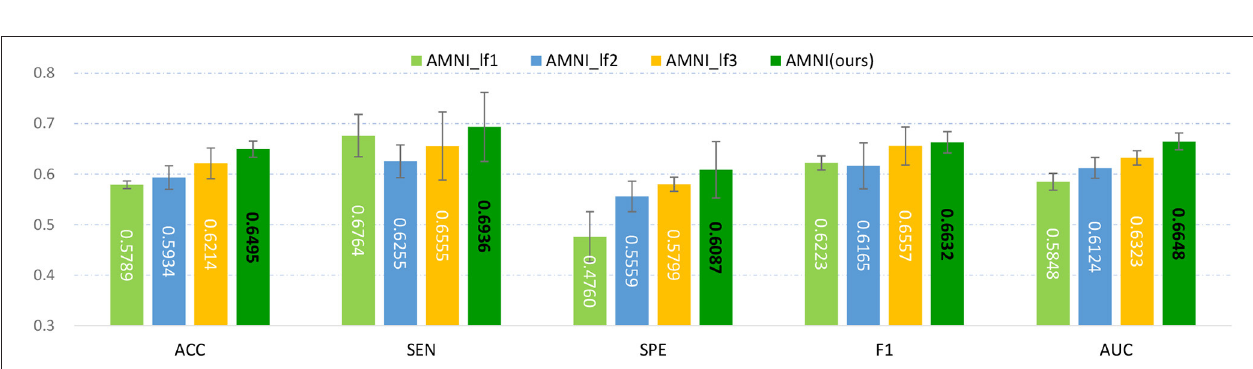
FIGURE 8 | Experimental results of late fusion method and our AMNI method in MDD vs. HC classification. Note that AMNI_lf1, AMNI_lf2, and AMNI_lf3 denote that the weight ratio between fMRI and sMRI branch is 0.2